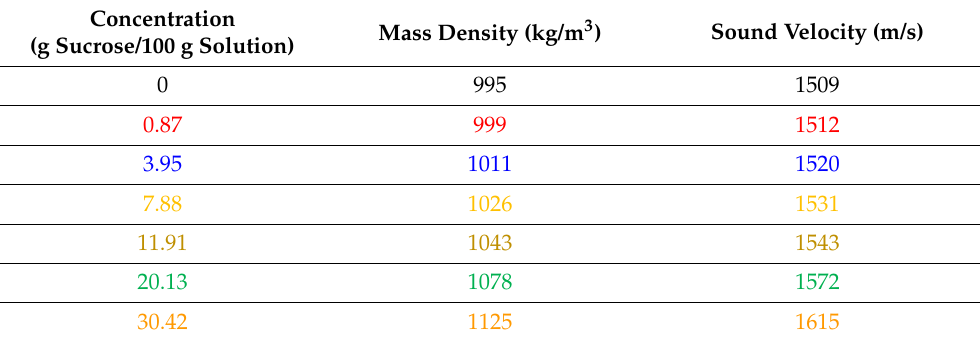
Figure 5. ( a ) Transmission curves calculated for a set of sucrose concentrations in an aqueous sugar solution, with ( b ) the same as ( a ) for a measurement on the surface of the washer. ( c ) Dip frequencies as functions of the associated sugar concentration. Table 2. Mass density and sound velocity of the different concentrations of the sucrose aqueous sugar solution